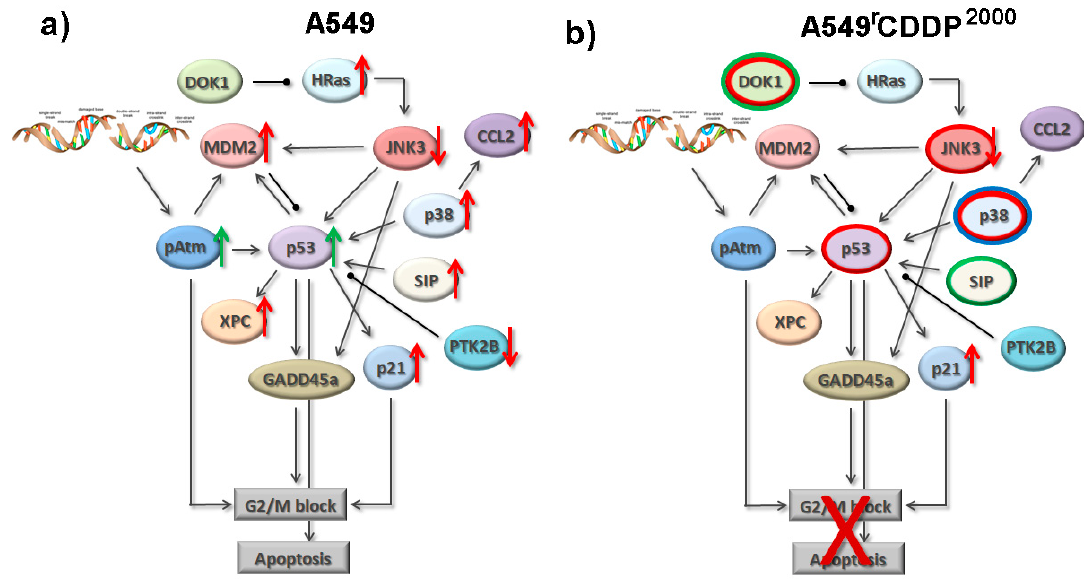
Figure 6. Model of resistance-associated signalling alterations indicating significant changes of mRNA expression (red arrows) or protein expression (green arrows) after cisplatin treatment in A549 and A549 r CDDP 2000 cells, as well as an increase in basal mRNA levels (red circles), protein levels (green circles) or basal kinase activation (blue circles) in A549 r CDDP 2000 ( b ) compared to A549 ( a ) cells. The model is based on the data presented and described here and the data previously published [6].